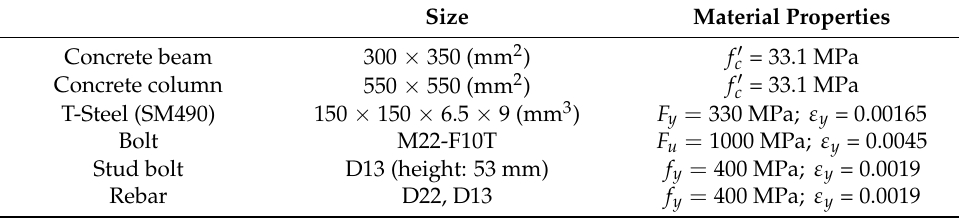
Table 5. Material properties used in finite element analysis (Specimens #1 to #3 by [28]). Size Material